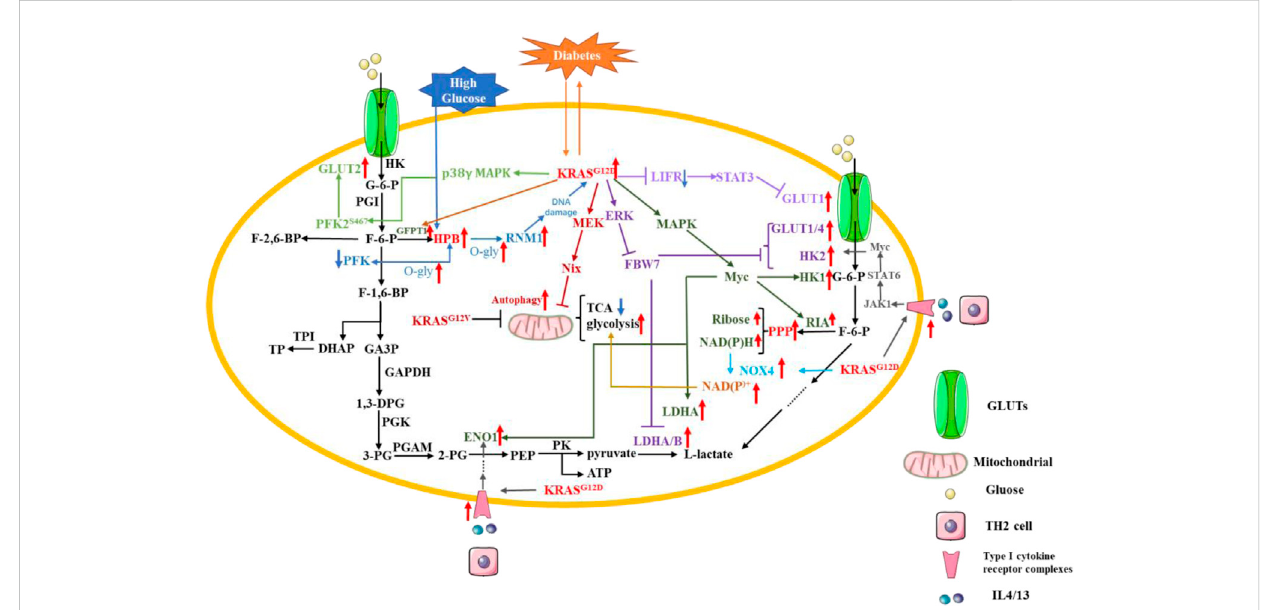
FIGURE 4 KRAS mutation in PDAC glucose metabolic reprogramming. Pancreatic cancer cells facilitate glycolysis under adequate oxygen conditions; this is known as the “ Warburg effect. Red arrow: The expression of related gene is upregulated. Blue arrow: The expression of related gene is downregulated.